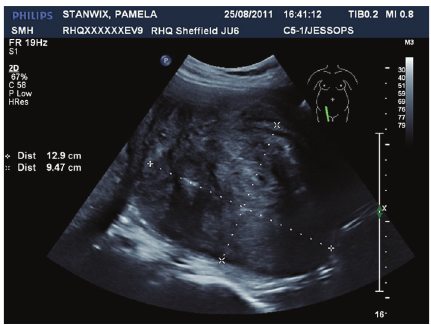
Figure 2: Cervical fibroid size at 36 weeks 12.9 × 9.47